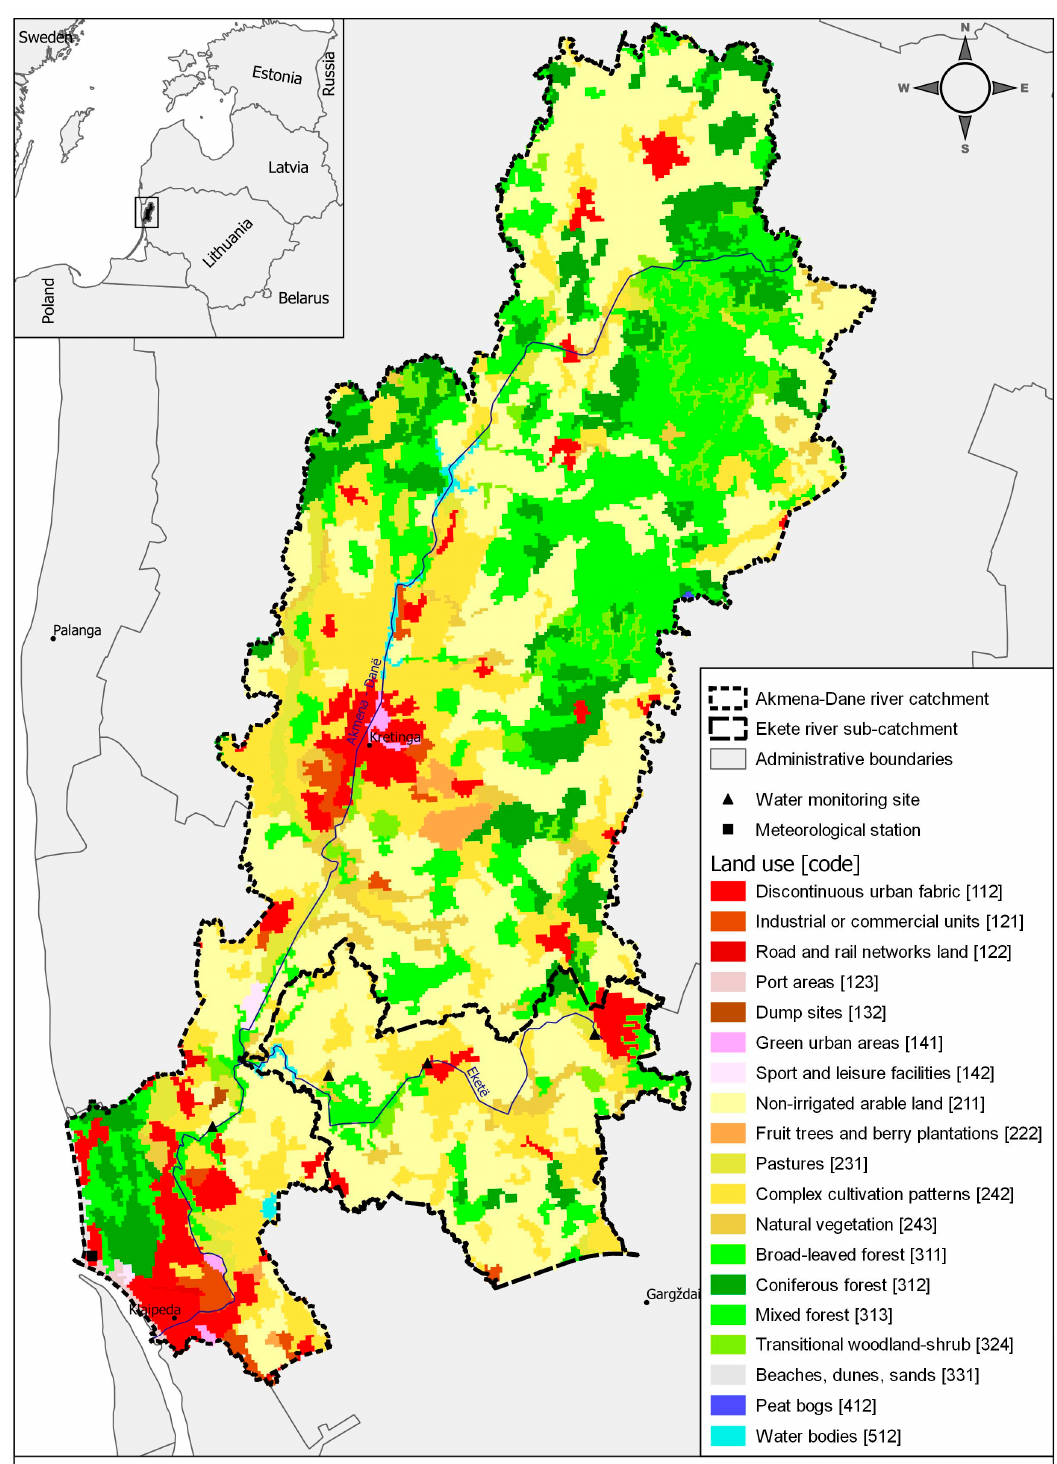
Figure 1. The catchment of the Akmena-Dan ė with the Eket ė sub-catchment under the different land use in 2012. The land use from CORINE data was visualized using QGIS (3.4.1) software [23,24]. The largest tributary of the Akmena-Dan ė is the Eket ė River. It is 23 km long and its sub-catchment occupies 93.3 km 2 . Almost 5% of the Akmena-Dan ė catchment area was urban use and 1.4% was in industrial, commercial, roads, rails and ports in 2012 [25].